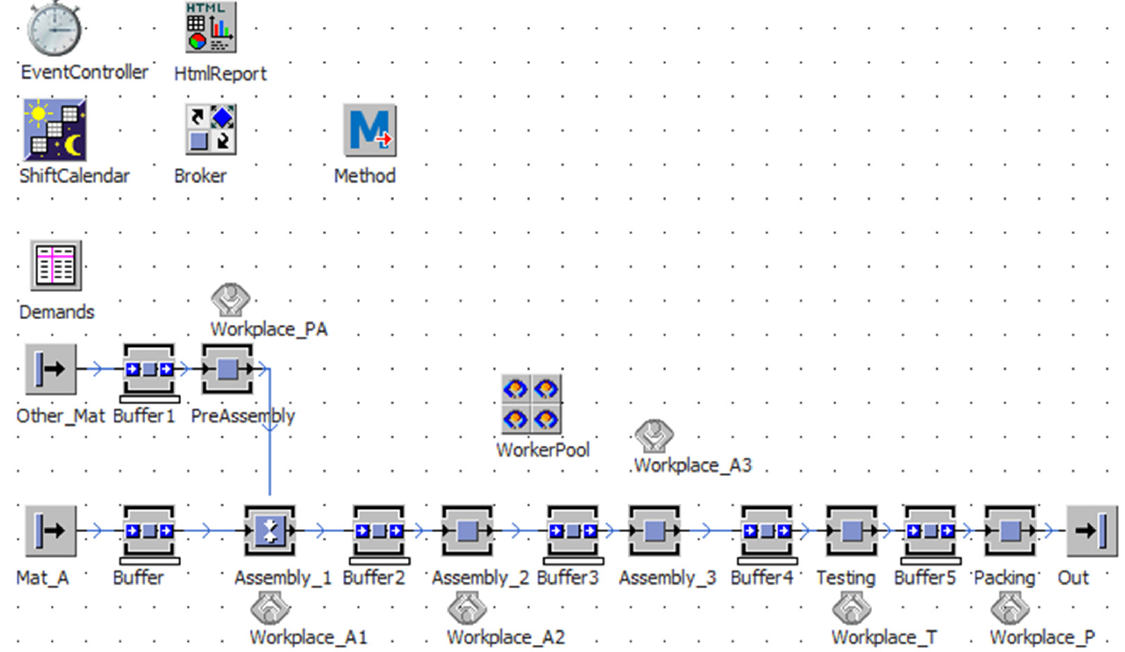
Figure 8. Simulation model of the assembly line—improved state. The algorithm for Process Innovation by Increasing Ideality was then applied to the improved state of the process. Firstly, ideas for the innovation of the whole process were collected by using the 3I method for the process as a whole. Then, ideas were searched to